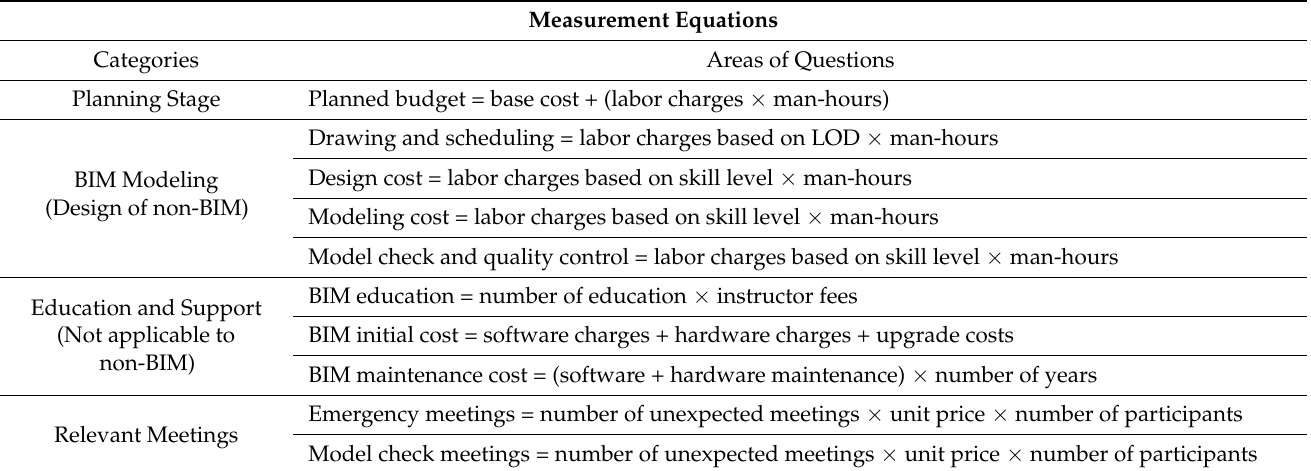
Table 3. Equations for quantitative measures. Measurement Equations Areas of